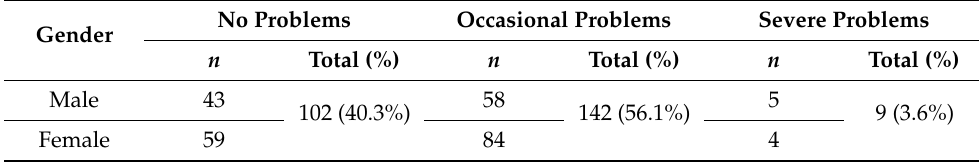
Table 3. Descriptive statistics of mobile phone use by